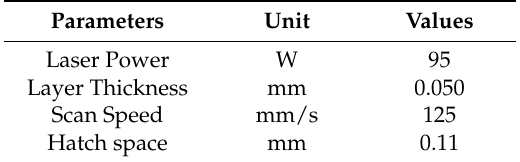
Table 1. Processing parameters used in the SLM of TI6AL4V samples.